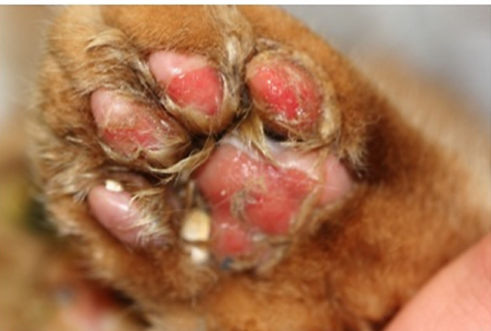
Figure 10. Excoriations of paws in a cat with VS-FCV infection. ©Katrin Hartmann. LMU Munich.